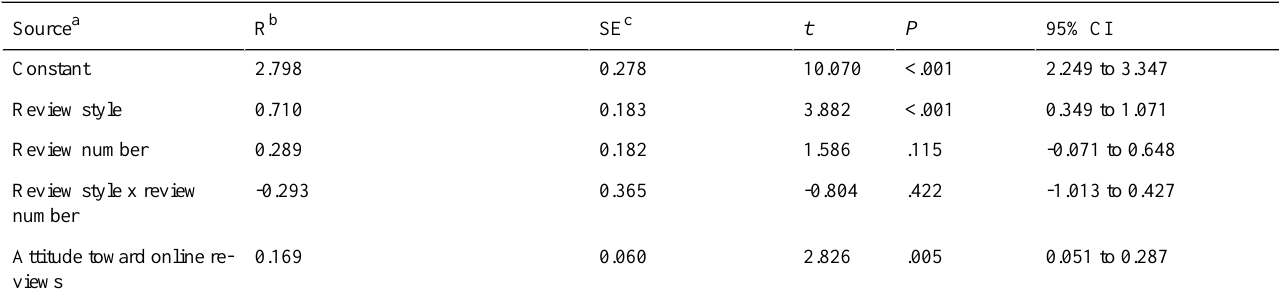
Table 2. Results of the moderated mediation analyses for the outcome variable, perceived expertise of the reviewer.